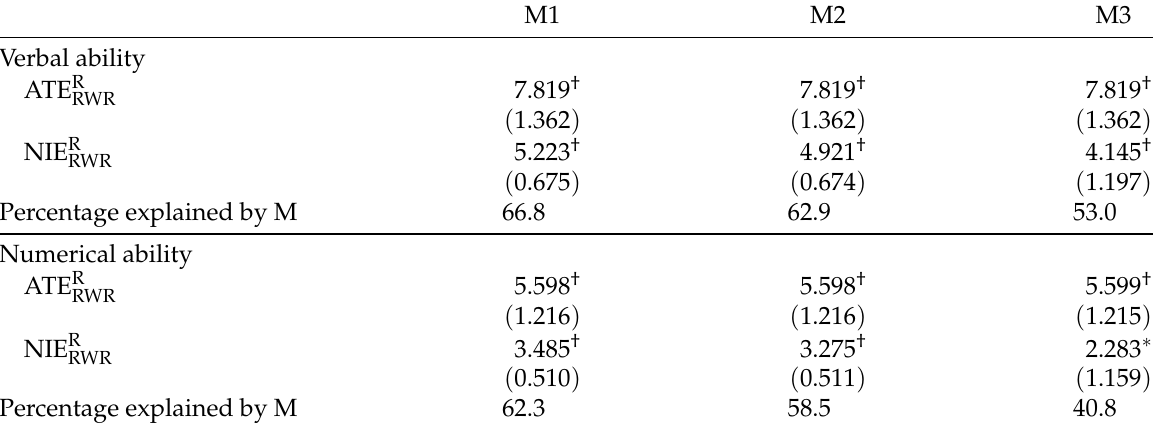
Table 2: Decomposition of G1 education effect on G3 verbal ( n = 1, 898) and numerical ability ( n = 1, 884) into direct and indirect effect via G2 cognitive ability